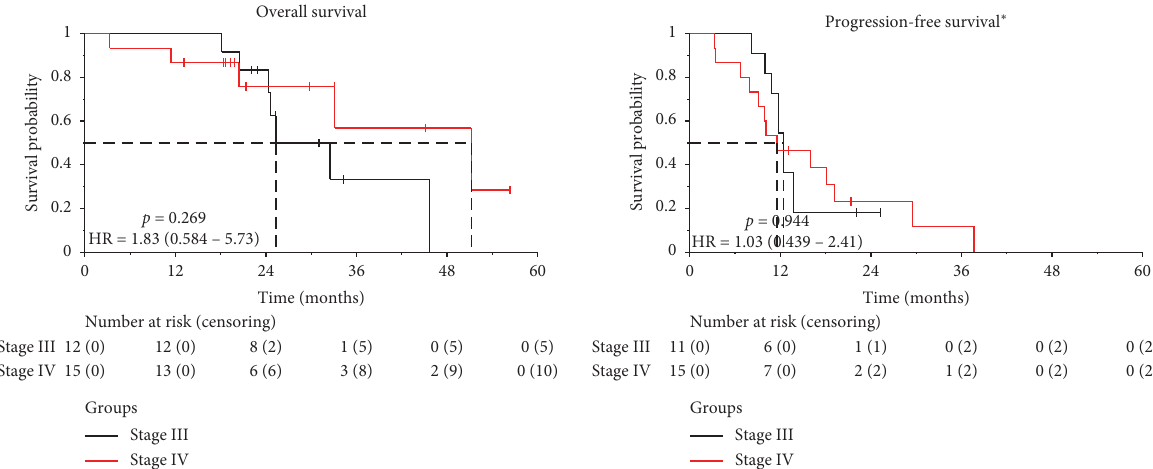
Figure 2: Overall survival and progression-free survival by disease stage in patients with peritoneal metastases from epithelial ovarian cancer treated with neoadjuvant systemic chemotherapy followed by cytoreductive surgery and hyperthermic intraperitoneal chemo- therapy. ⋆ Progression-free survival was only calculated in patients with CC-0 or CC-1. HR: hazard